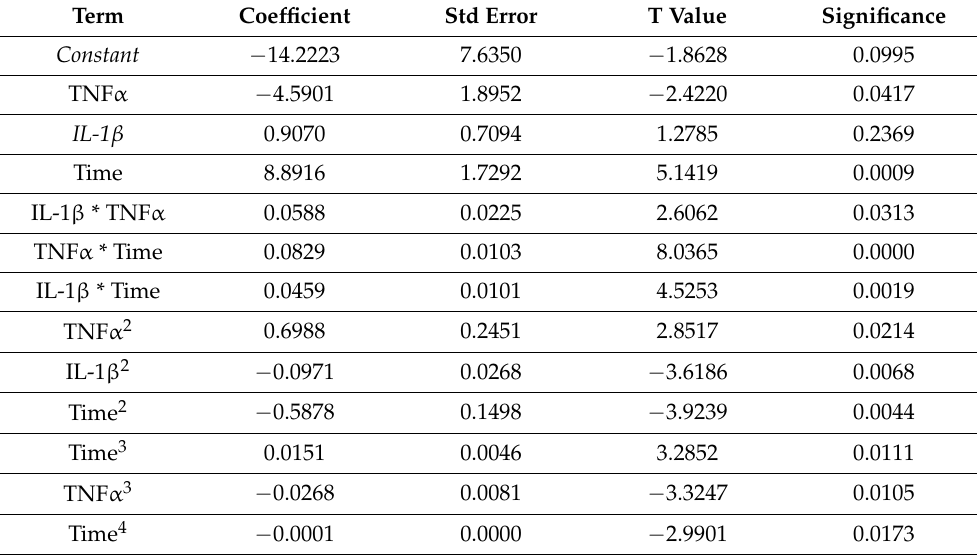
Table 1. MMP9 model coefficient table depicting the used terms of the model with their coefficient value, standard error, t value and significance level; italic terms are not significant but remain in the